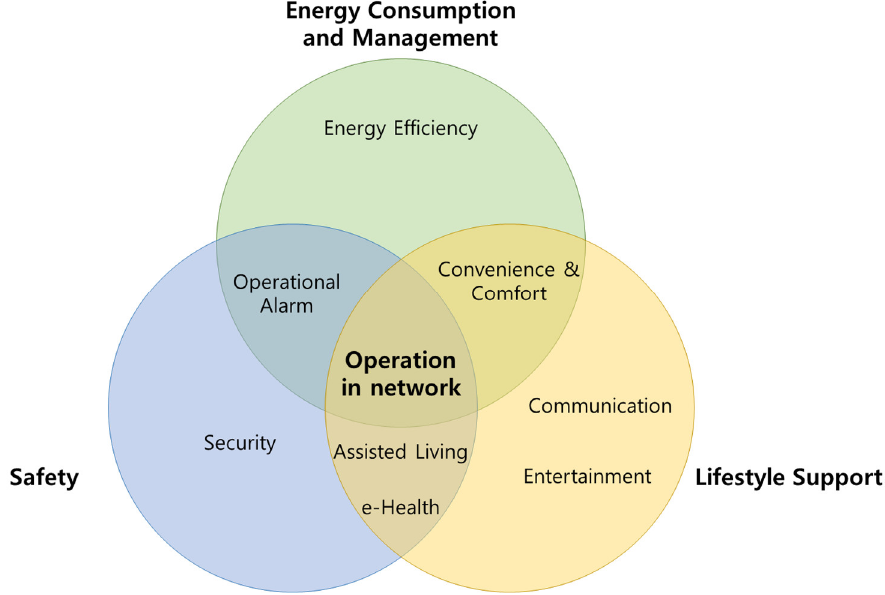
Figure 2. Types of smart home services reprinted with permission from Ref. [16] .